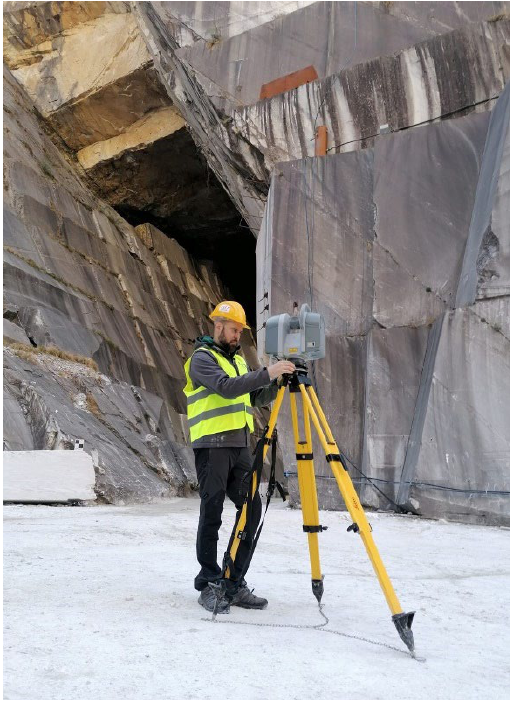
Figure 3. Trimble © TX8 laser scanner during setting up of data acquisition.